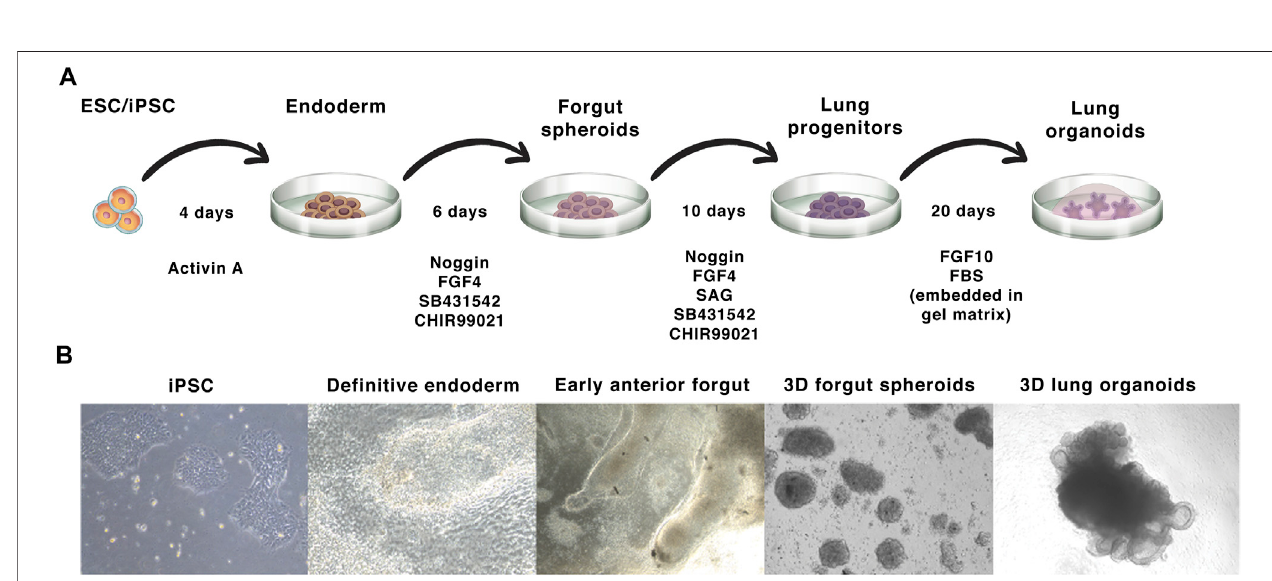
FIGURE 2 | Lung organoids: (A) — The main sources for the creation of the human LOs. (B) — The main application of human LO models.